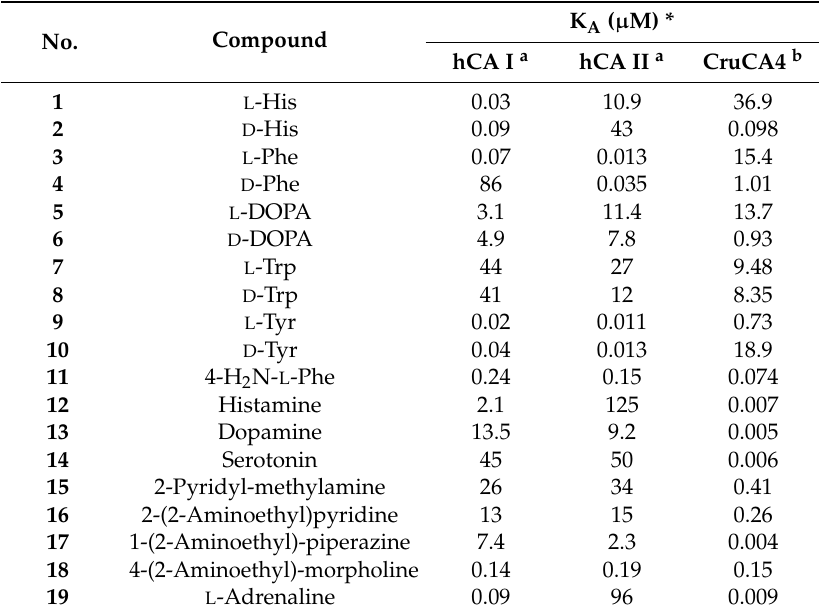
Table 3. Activation constants of hCA I, hCA II and the coral CruCA4 with amino acids and amines 1 – 19 . Data for hCA I and II are from Di Cesare and colleagues [43]. K A ( µ M) * No. Compound hCA I a hCA II a CruCA4 b 1 L -His 0.03 D